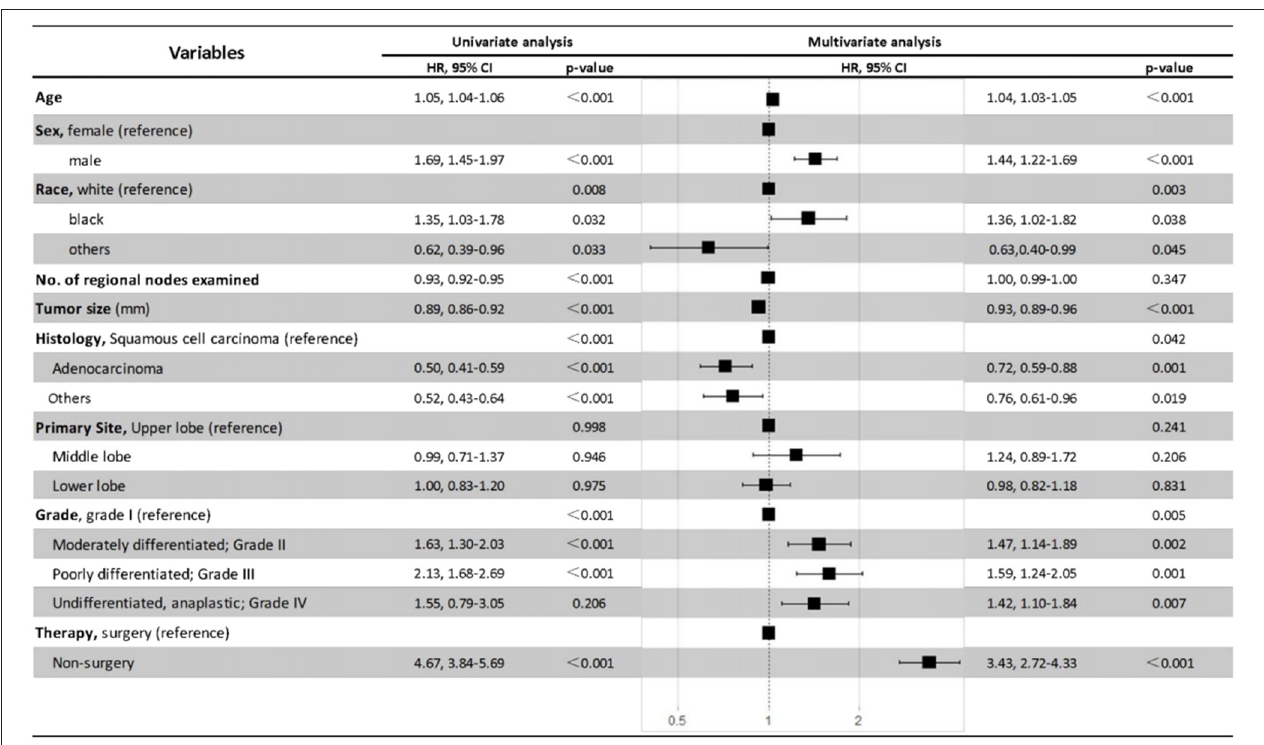
FIGURE 6 | Univariate and multivariate analysis for overall survival of the